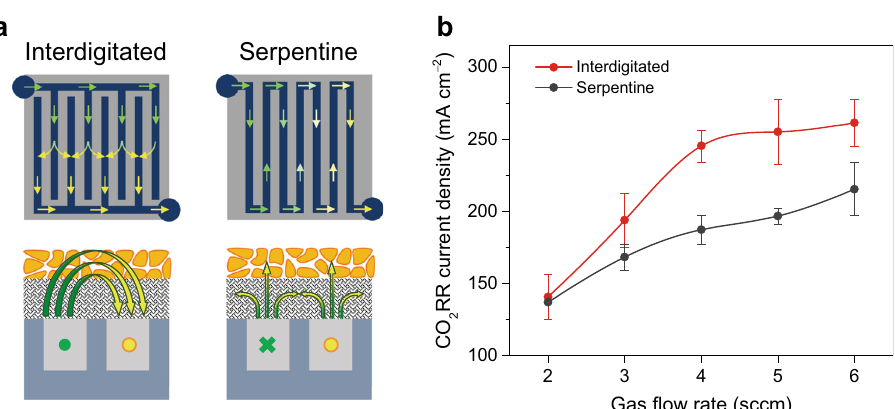
Fig. 5 Effect of gas-diffusion channels on the CO 2 RR in GDE cell. a Schematic illustration of the gas fl ow fi elds generated by the interdigitated and serpentine channels. b Partial current densities for CO 2 RR on the Cu/C/PTFE electrode (with a 50% PTFE mass ratio) with two different channels at − 1.0 V with various CO fl ow rates. The error bars represent the standard deviation of three independent 2 gas